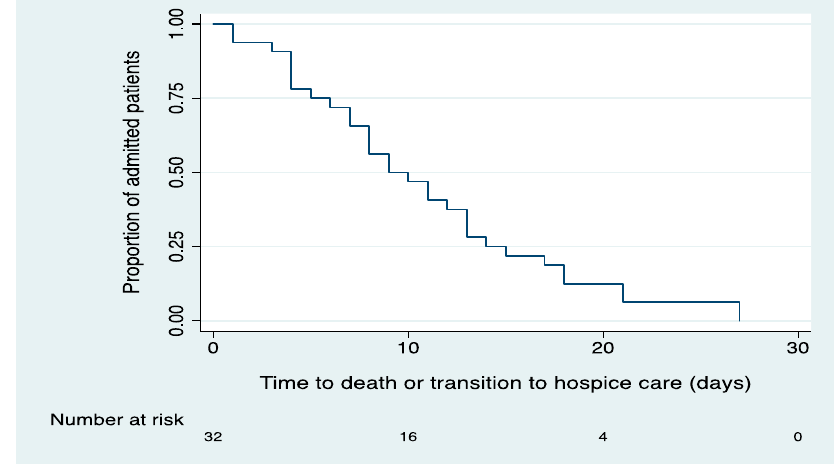
Figure 3. Time from admission to death / transition to hospice care in COVID-19 hospitalizations (n = 32; patients who died / transitioned to hospice).